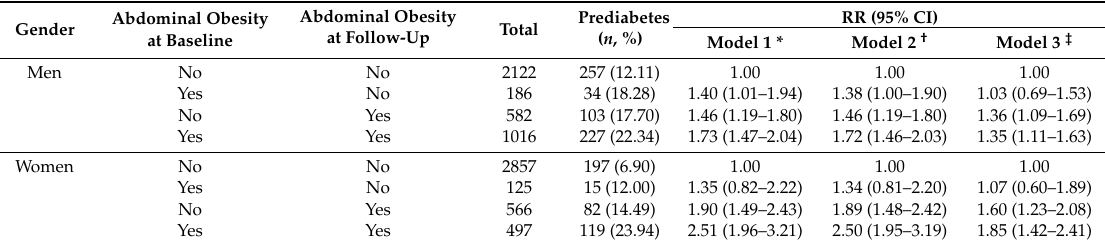
Table 3. Risk of prediabetes by abdominal obesity at baseline and